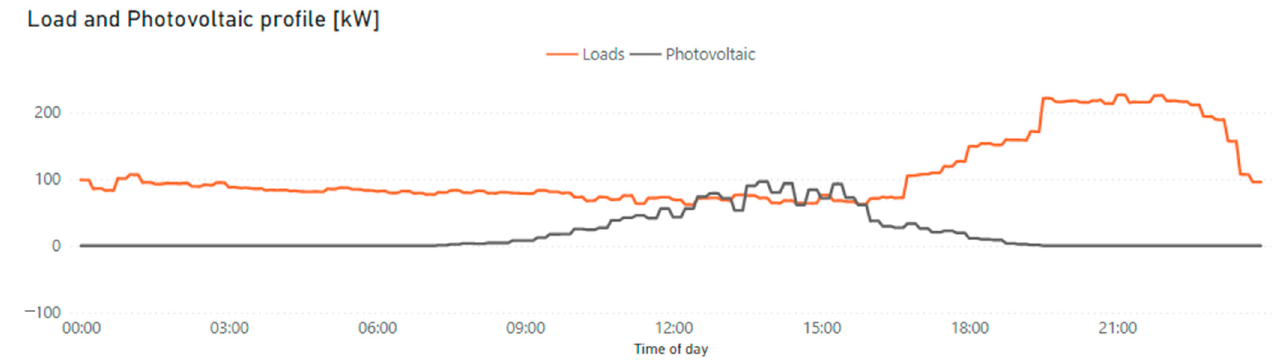
Figure 8. Load and PV generation profiles adopted in all the simulation scenarios.